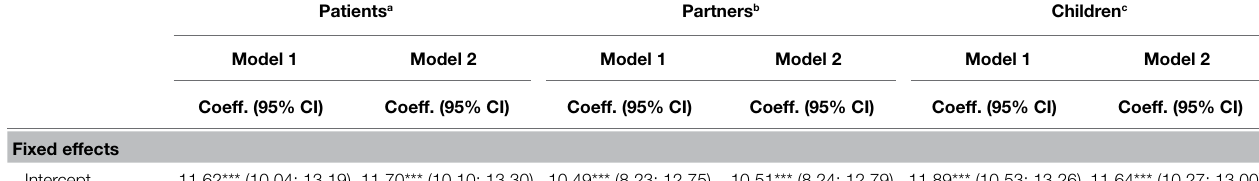
TABLE 4 | Associations with child externalizing problems from the three different rating perspectives.